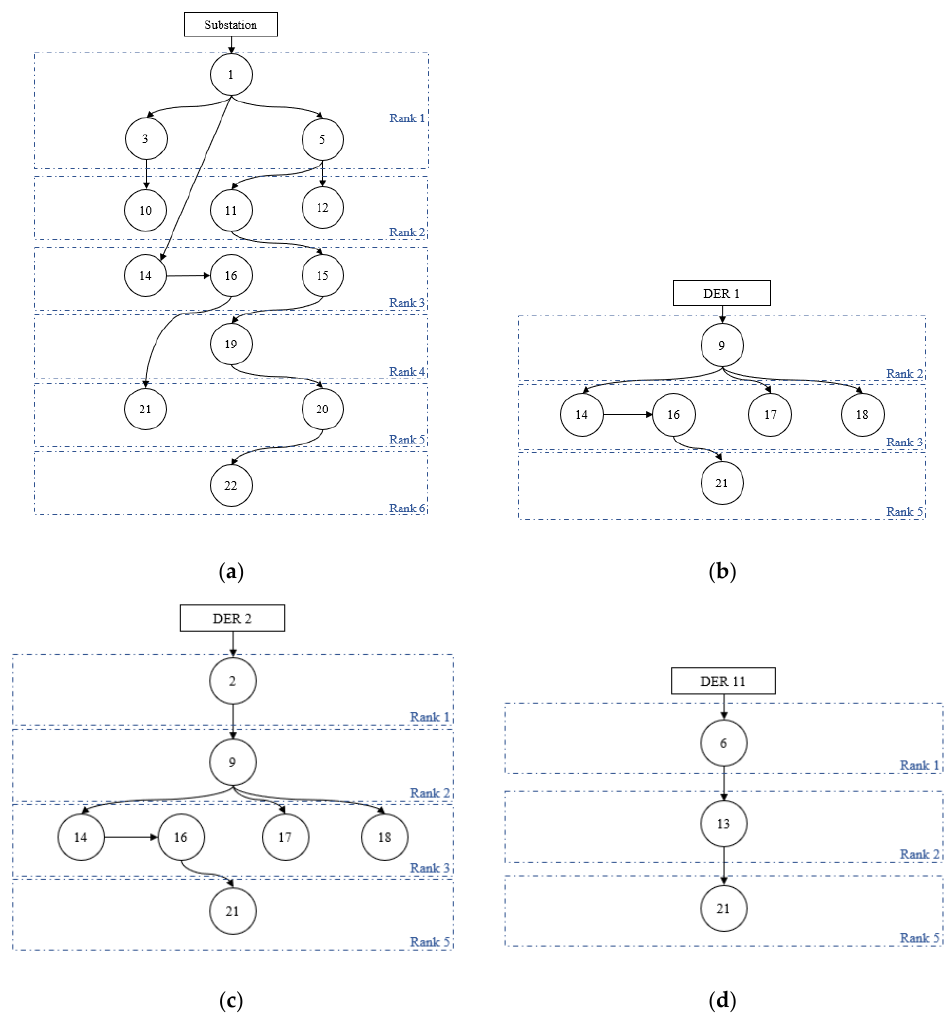
Figure 7. Equivalent network of the ( a ) substation; ( b ) DER 1; ( c ) DER 2; ( d ) DER 11. After all connected commons are identified, they are configured based on their ranks and connected to each other according to the power flow directions represented as tion of the generators supplying each common should be equal to one.